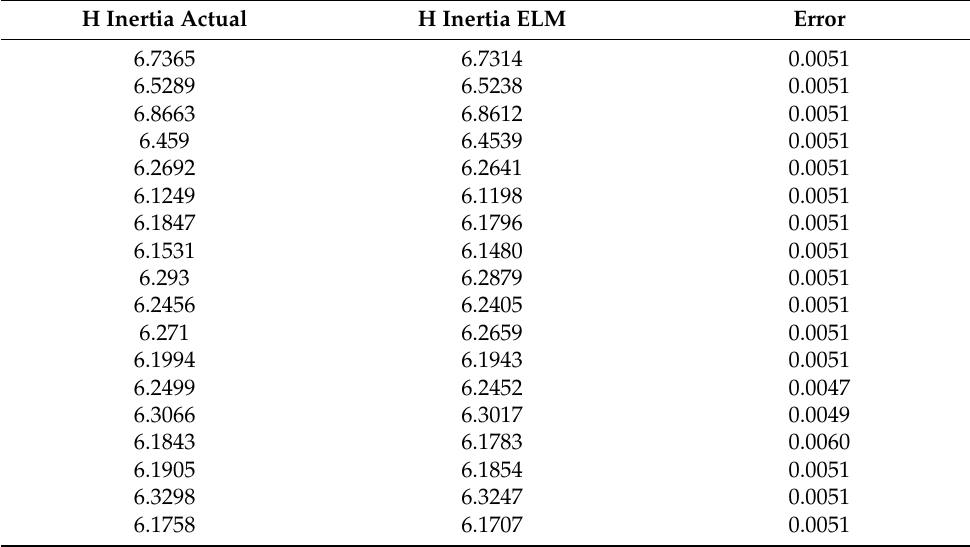
Table 4. Detailed features of the results are given in Figure